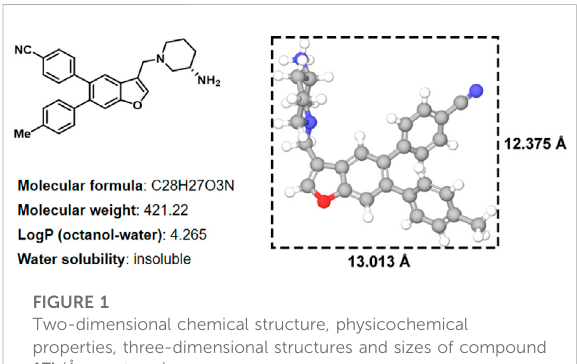
FIGURE 1 Two-dimensional chemical structure, physicochemical properties, three-dimensional structures and sizes of compound 17i (Å,